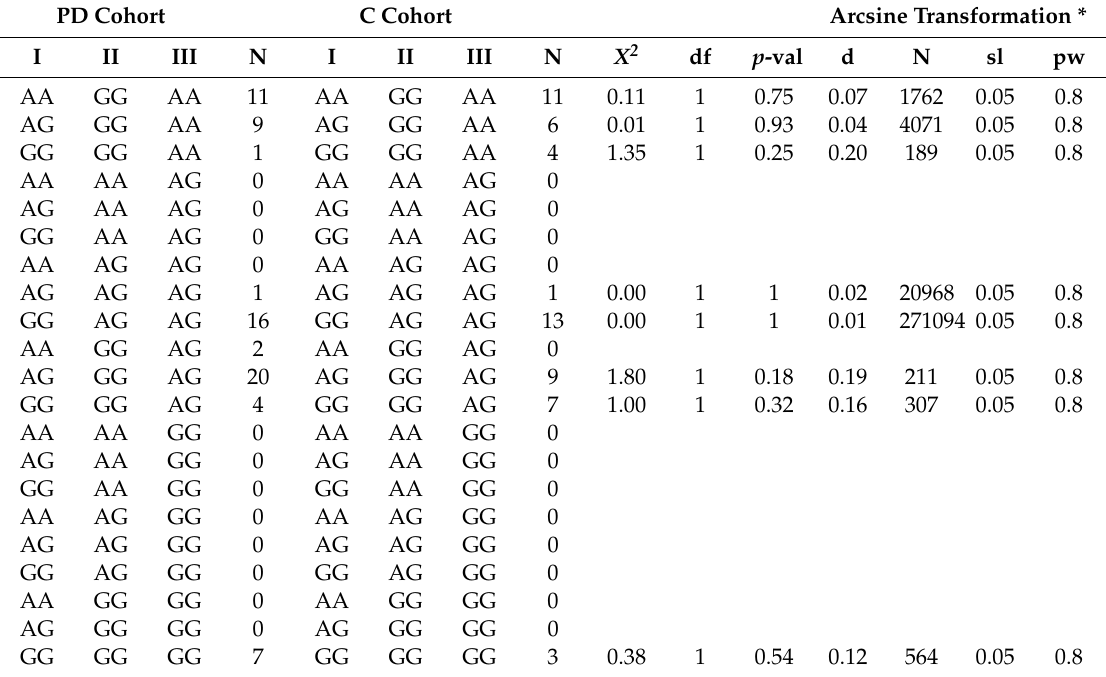
* proportion power calculation for binomial distribution. (I) rs11240569, (II) rs708727, (III) rs823156, (d) Cohen’s d, (C) control, (df) degrees of freedom, (N) number of individuals, ( p -val) p value, (PD) Parkinson’s disease, (pw) power of test, (sl) significance level, (SNP) single nucleotide polymorphism.